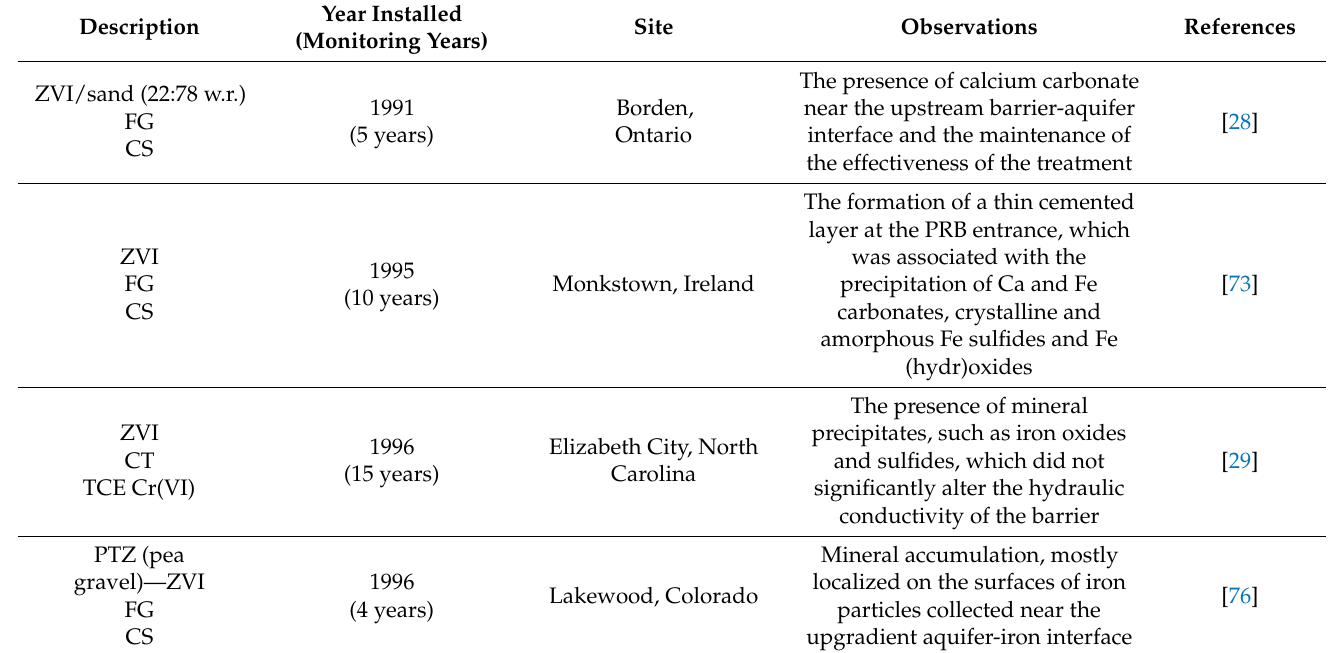
Table 2. In situ observations of PRB hydraulic